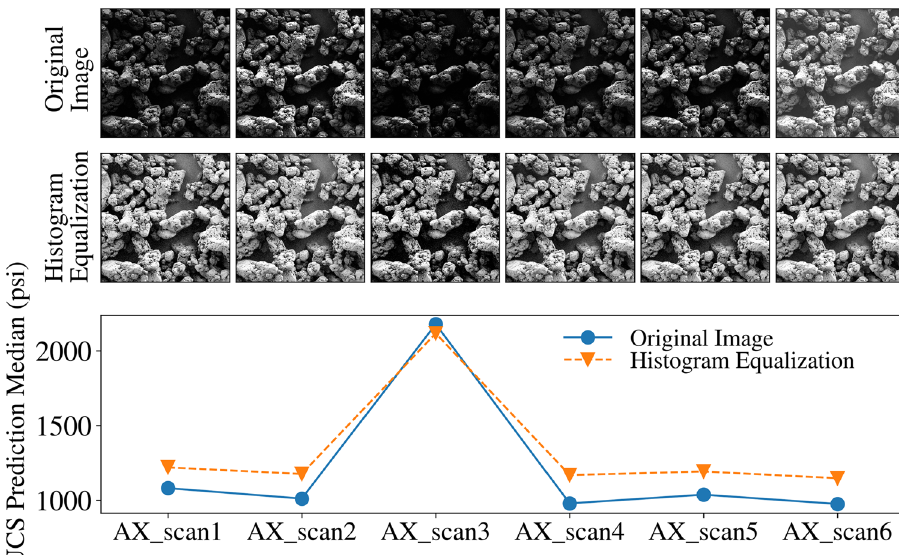
Fig. 5 Example of data distribution shift resulted machine learning model mistakes. The task is to predict material mechanical strength from feedstock material SEM images. The authors take different scans of the same microstructure using different microscope settings. Ideally, ML model predictions should only depend on the microstructure content, not the microscope settings. However, results show that darker images are consistently predicted to have bigger ultimate compressive strength (UCS) values, even with image normalization 61 . The x-axis shows experiment id. The fi rst row shows example images from the given experiment. The second row illustrates the effect of one image normalization method (i.e., histogram